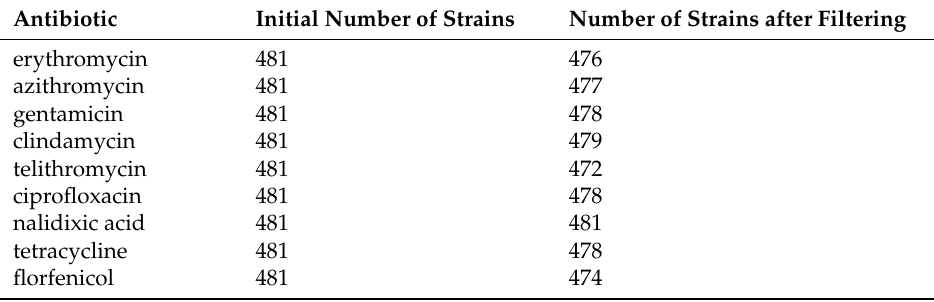
Table A1. C. jejuni . Number of genomes for each antibiotic.